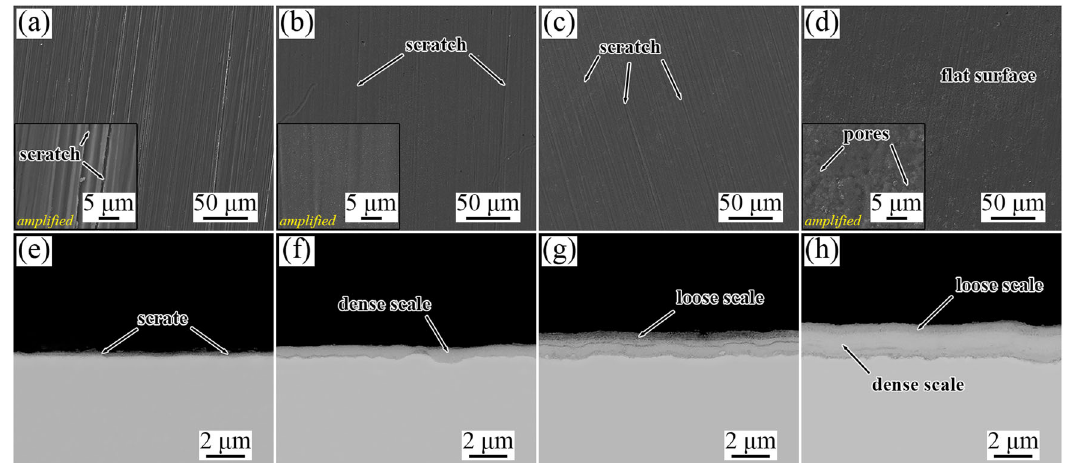
Fig. 3 SEM micrograph of 37Mn5 steels after oxidation at 600 °C. a Surface microstructure for 16 min in air. b Surface microstructure for 30 min in air. c Surface microstructure for 16 min in kerosene. d Surface microstructure for 30 min in kerosene. e Cross-sectional microstructure for 16 min in air. f Cross-sectional microstructure for 30 min in air. g Cross-sectional microstructure for 16 min in kerosene. h Cross-sectional microstructure for 30 min in